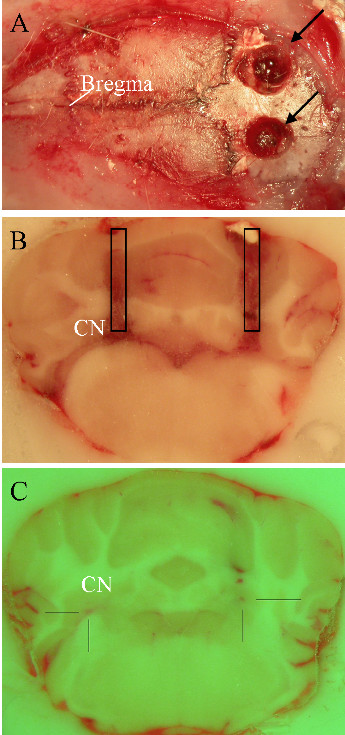
Illustration of bilateral implantation of cerebellar guides. A: Two holes (black arrows) in the skull to implant the guides. B: Probes are inserted in cerebellar nuclei (CN). C: Bilateral injection of Ab. Brain sections at the level of cerebellar nuclei in B and C.